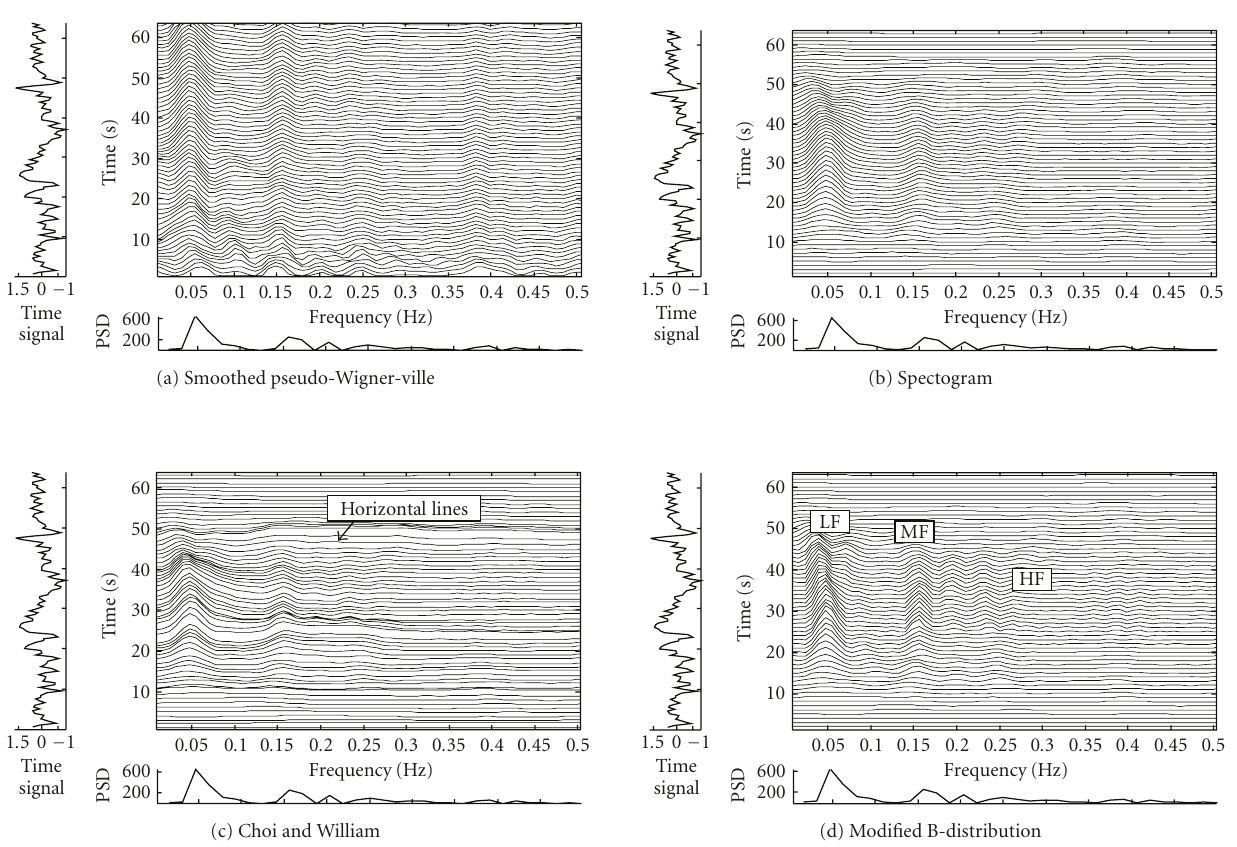
Figure 3: TFD for HRV related to seizure: (a) SPWVD; (b) SP; (c) CWD; and (d)